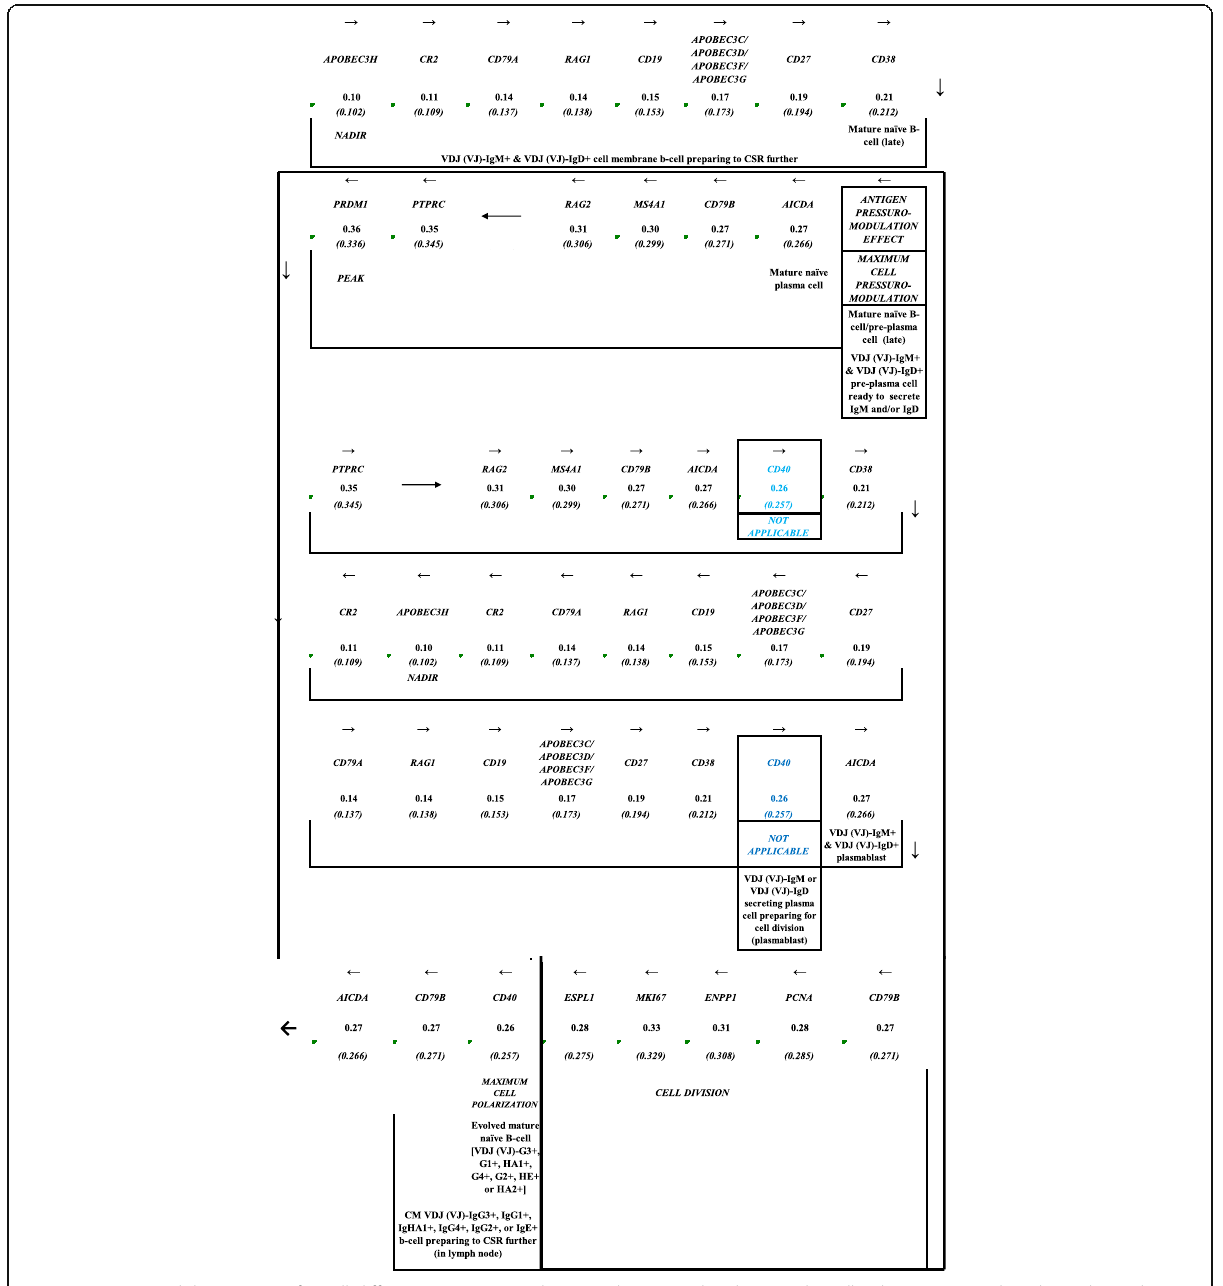
Fig. 1 Pressuromodulation map of B-cell differentiation stages. There are three completed maximal B-cell polarization periods with another to begin (CD40R+), two half-refractory B-cell polarization periods (CD40R±), and four full-refractory B-cell polarization periods (CD40R-) to the 1st generation CM VDJ (VJ)-IgG3+, IgG1+, IgHA1+, IgG4+, IgG2+ or IgE+ (excluding IgA2+) Evolved Mature naïve B-cell preparing to CSR further in the lymph node (2nd phase) after the completing the Immature B-cell phase in the myeloid bone marrow (1st phase). The antigen pressuromodulation effect- mediated extra-lymph nodal long-lived B-plasma cell/plasmablast secretory antibody phase (3rd phase) takes place in the periphery/tissue nidus. Note: The classical pathway B-cell maturation pressuromodulation map is shown, however the map applies to the parallel alternate B-cell maturation path- way wherein the T-cell independent antigen-mediated toll-like receptor (TLR) positive pressuromodulation effect (i.e. endocytic) substitutes for the CD4R+ CD40LG T-cell-mediated CD40R B-cell polarization pressuromodulation effect. † , upper esebssiwaagoT Q units range, 0.41 – 0.36. Black, CD40 at maximum cell polarization potential (CD40R+). Dark blue, CD40 at half-refractory (CD40R±). Light blue, CD40 at full-refractory (CD40R-). Thick black lined large rectangu- lar box, extra-nodal secretory antibody